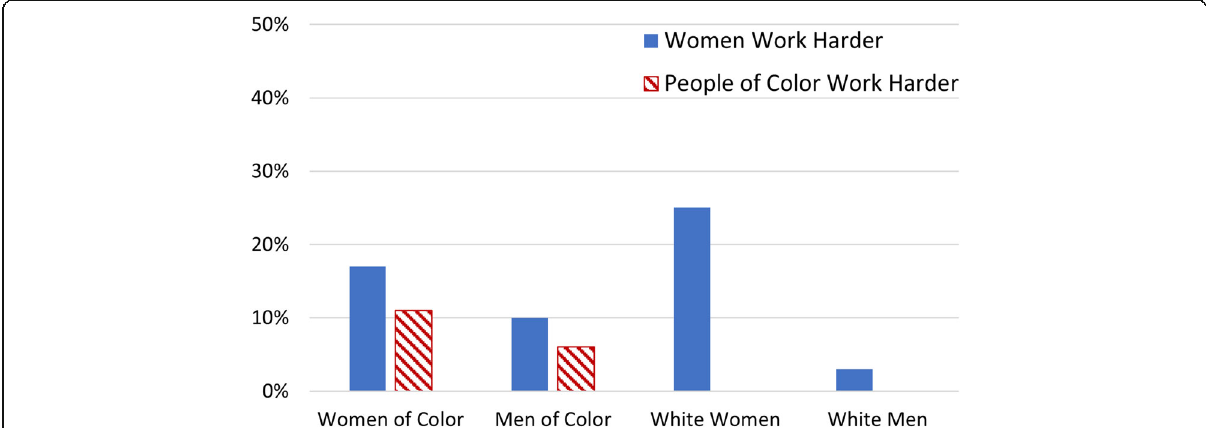
Fig. 6 Percent respondents who expressed theme that women and people of color work harder, by respondents ’ own race-by-gender category. We note that no student indicated that men or White students work harder than women or students of